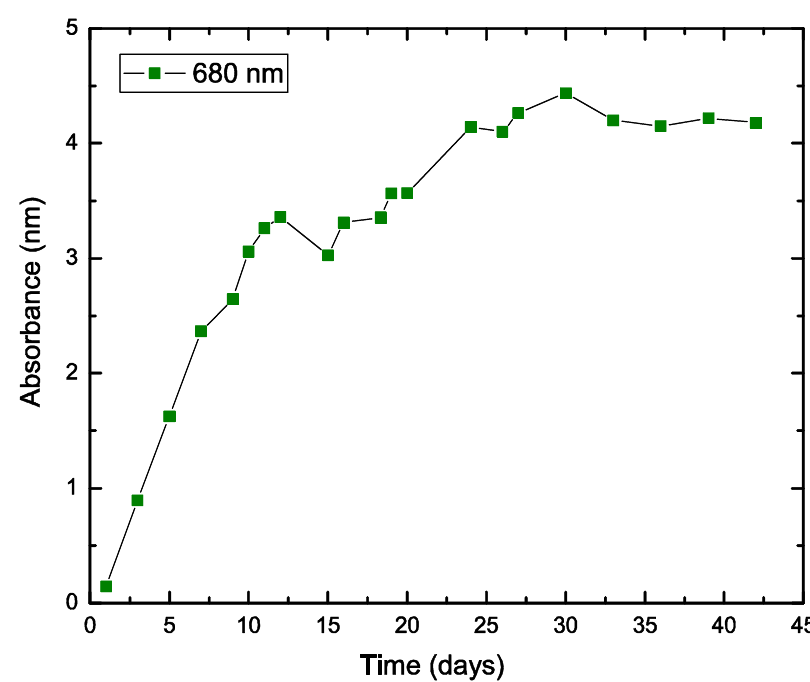
Figure 2. Growth curve of the microalgae culture according to absorbance at 680 nm.